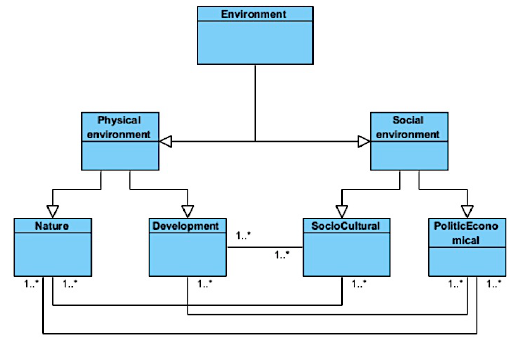
Figure 3. Social-physical perspective of